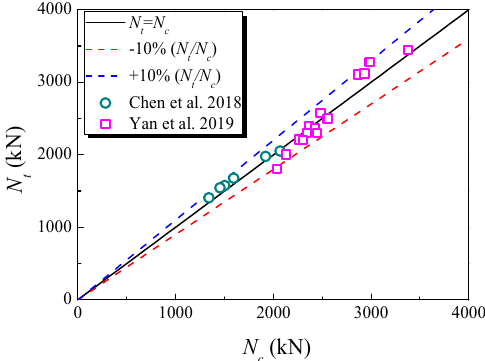
Figure 8. Comparisons of fi ber model with test data [29,30]. The full N - ε curves of partial specimens predicated by the fiber model in the present work ( γ = 3) are plotted in Figures 9 and 10. As illustrated in Figures 9 and 10, the calculations of the fiber model are in good agreement with the test results. In addition, for the strengthening effect of the high-strength steel and the constraint enhancement effect of the steel tubes on the core UHPC, the residual bearing capacity decreases slowly after reaching peak value, and subsequently remains basically constant, which illustrates that the favorable post-peak ductility and the residual bearing capacity of UHPCFST columns are showed.